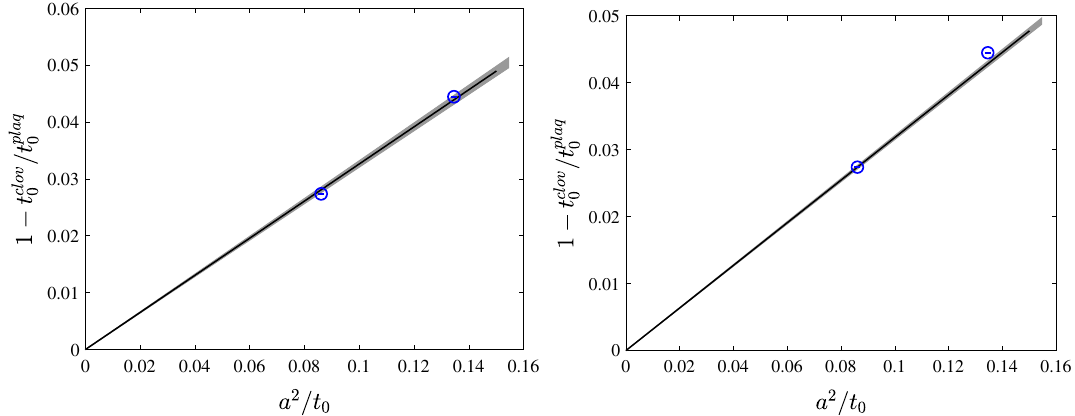
Fig. 1 The relative difference of the clover and plaquette definitions of the gradient flow scale t 0 , which vanishes in the continuum limit. The left plot shows a linear fit in a 2 through our data at two lattice spacings.